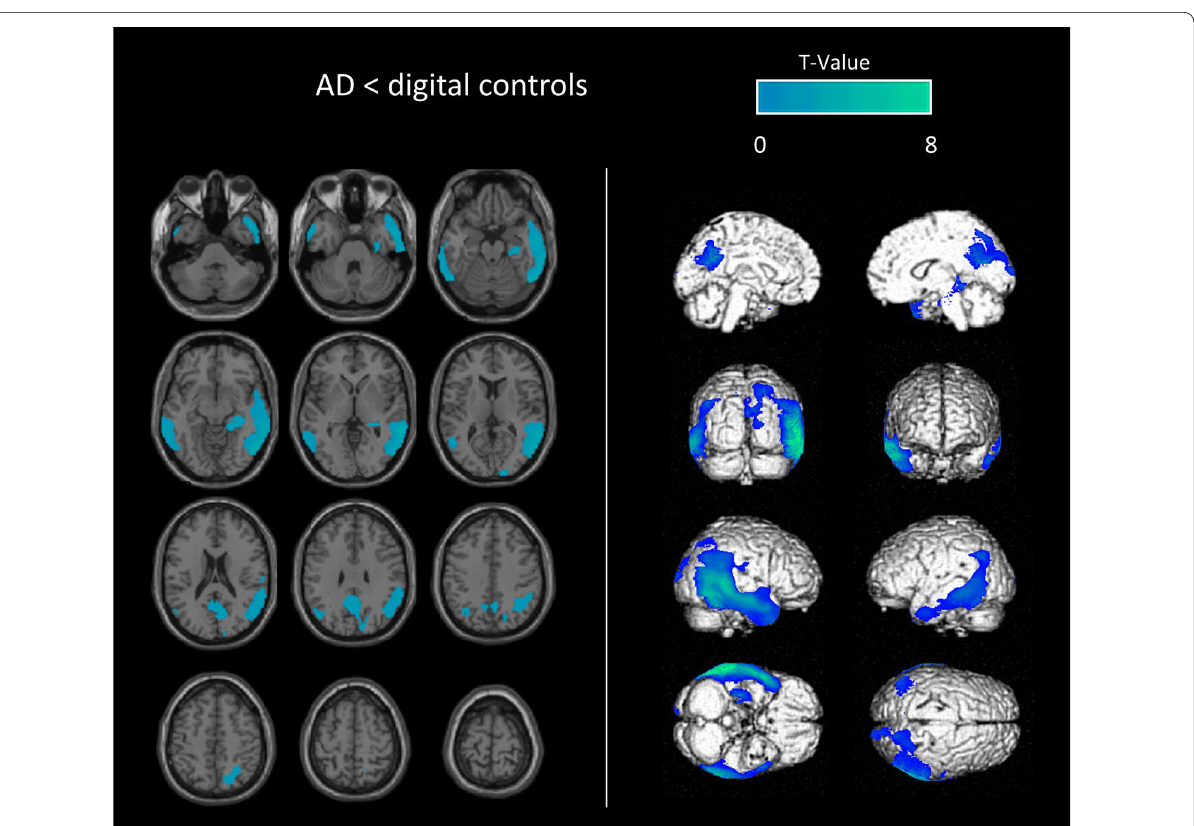
Fig. 4 Example of SPM‑T map images used for the visual analysis (semi‑quantitative analysis to digital controls) of a patient with AD (79‑year‑old man with MMSE score of 10). SPM‑T maps are projected onto two‑dimensional slices of T1‑weighted MRI (from the base to the top of the skull, left panel) and 3D‑rendered volumes (right